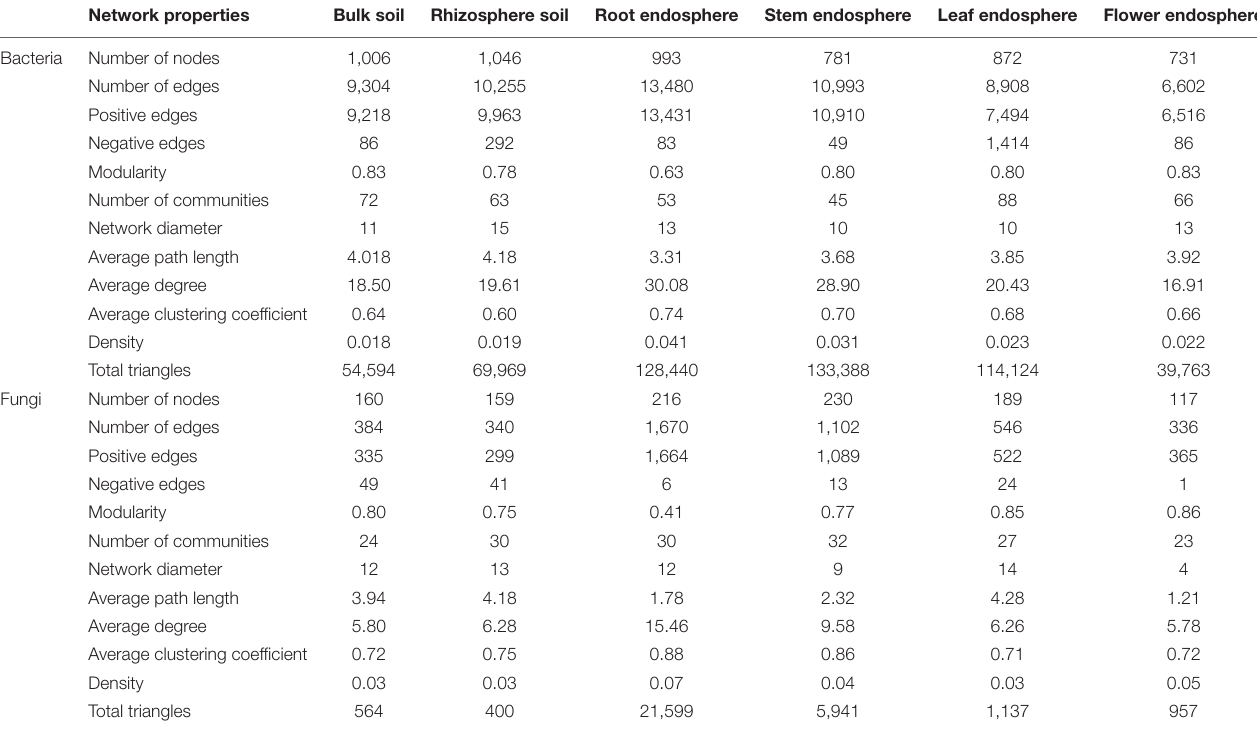
TABLE 3 | Topological properties of co-occurring bacterial and fungal networks within hemp compartments. Network